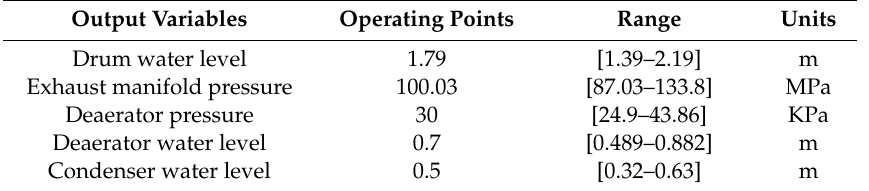
Table 1. The parameters used in the steam/water loop.